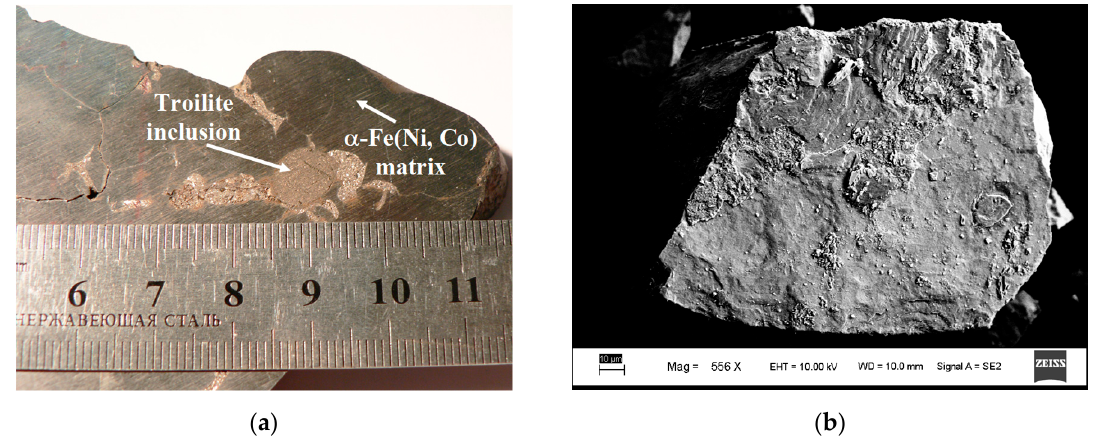
Figure 9. Troilite inclusion in Sikhote-Alin IIAB iron meteorite: ( a ) photograph of massive troilite inclusion in α -Fe(Ni, Co) matrix; and ( b ) scanning electron microscopy image of troilite particle extracted from Sikhote-Alin iron meteorite. Adopted from [11].